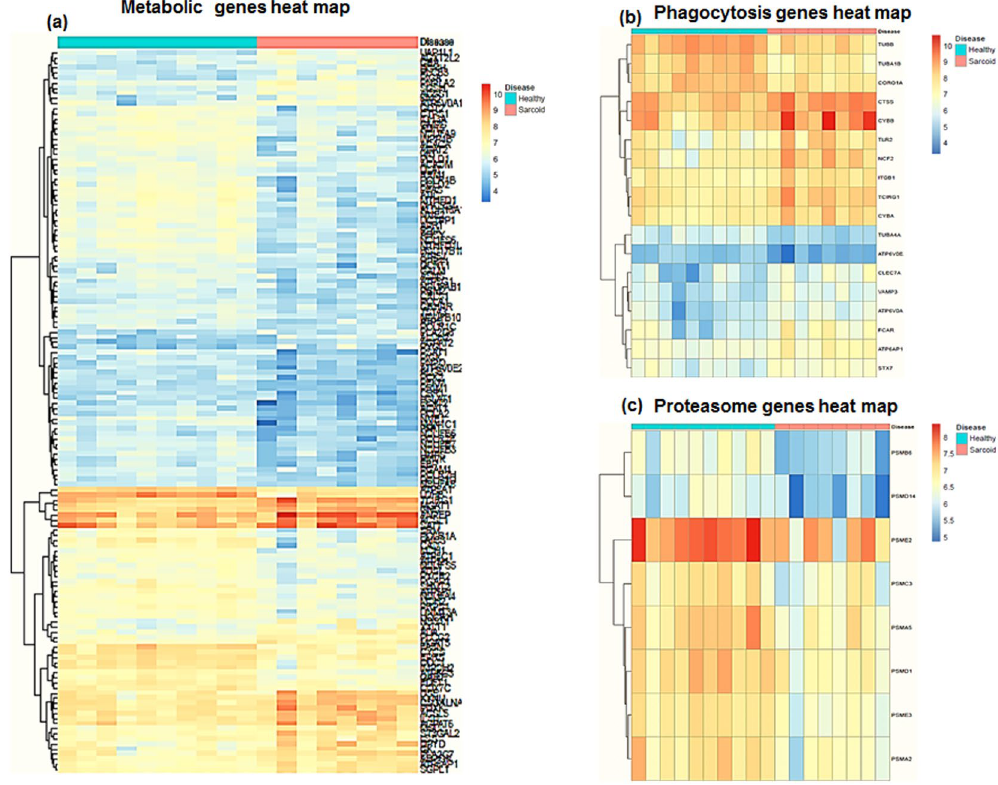
Figure 2. Heat maps of DE genes of three significant pathways in sarcoidosis versus healthy monocytes. ( a ) Heatmap of the 143 genes involved in metabolic pathways between two groups. ( b ) Heatmaps of 19 genes involved in phagocytosis and ( c ) Heatmaps of 9 genes involved in proteasome (log 2 -fold change > 0.5 & FDR < 5%). Dendrograms according to means identifying genes levels in all three pathways show two distinct clusters. Red shade represents high expression and blue shade represents low